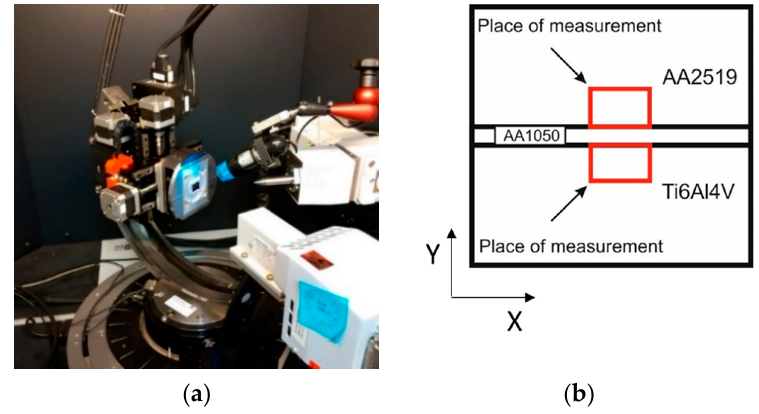
Figure 8. Bruker D8 Discover diffractometer with a Euler wheel ( a ), and locations of areas of self-stress measurements based on the X-ray method ( b ).